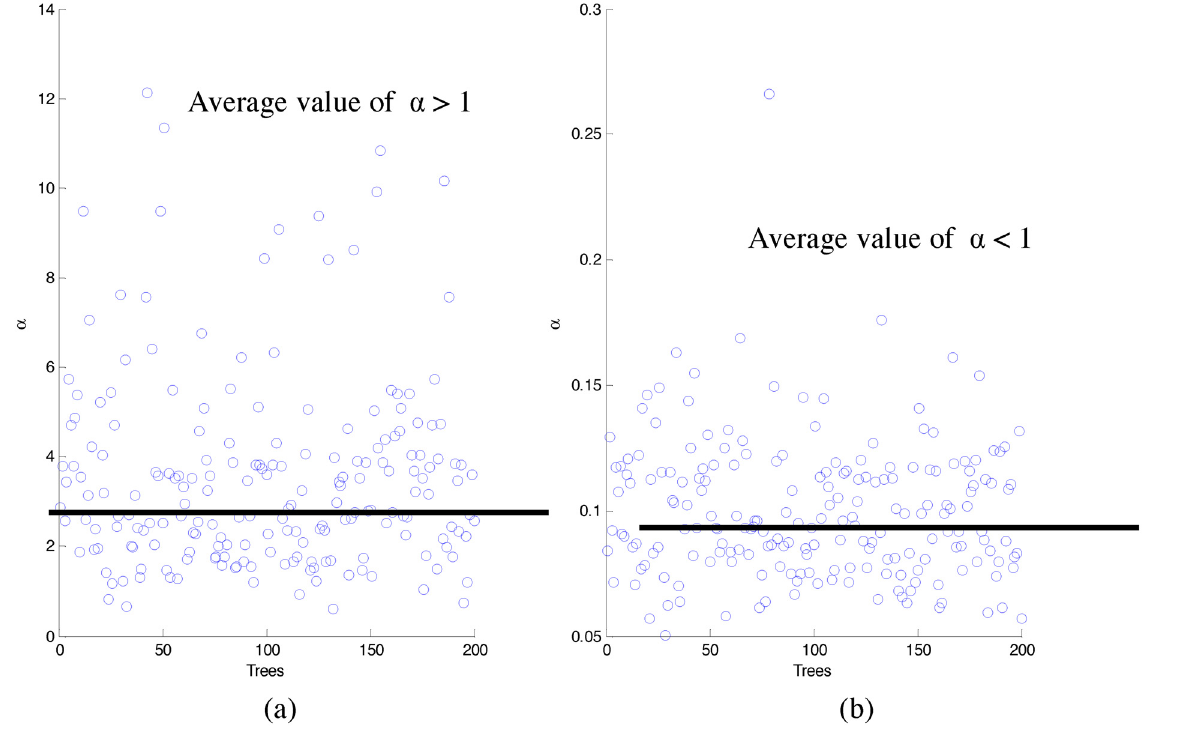
Fig 3. Scatter plot of α ’ s across the trees. (a) and (b) are scatter-plots for the first split of all the trees for α > 1 and α < 1 respectively.